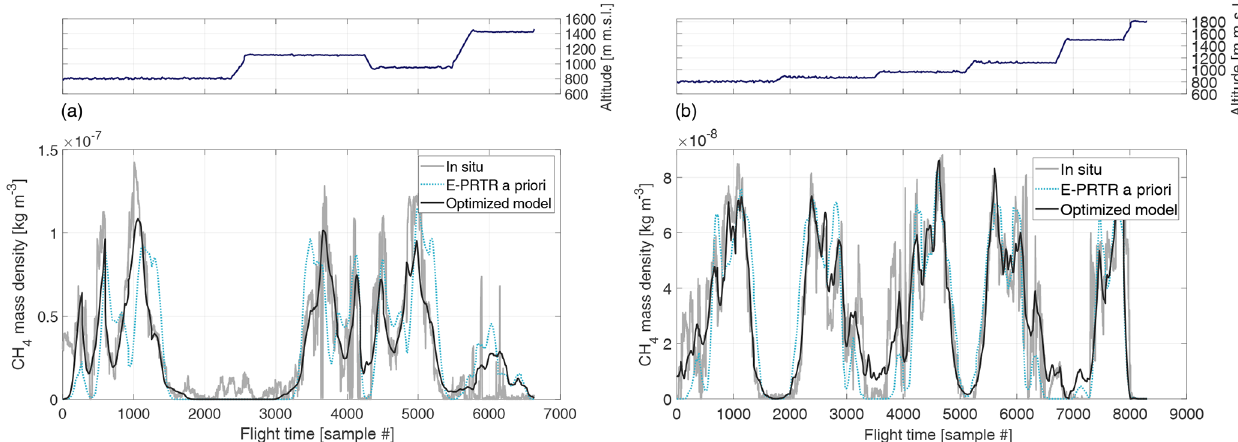
Figure 8. Time series of the in situ measured (gray) and modeled CH 4 mass density (solid black) with subtracted background as a function of flight time during the downwind wall phase of the morning (a) and afternoon (b) flight on 6 June 2018 with optimized source coefficients x i . The dotted light blue line corresponds to the same forward simulation using scaling coefficients deduced from E-PRTR 2017.